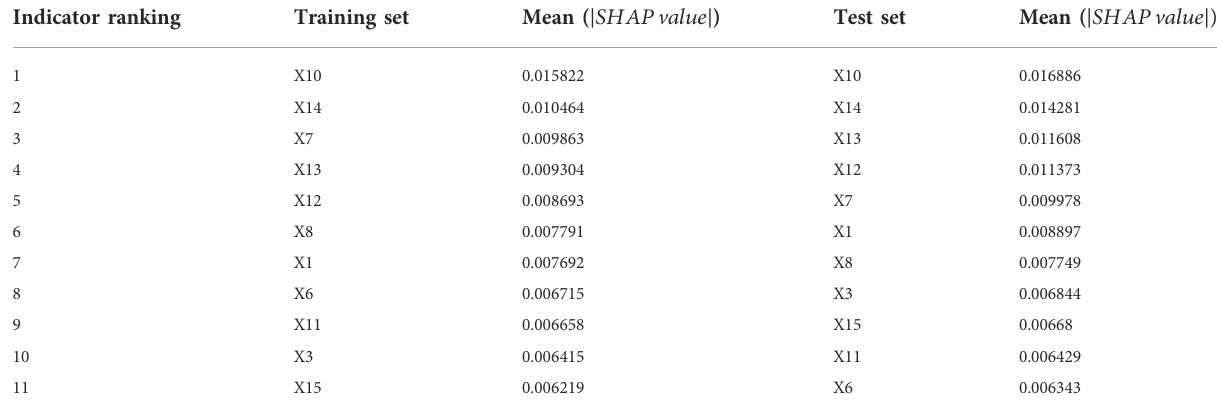
TABLE 6 Ranking of feature